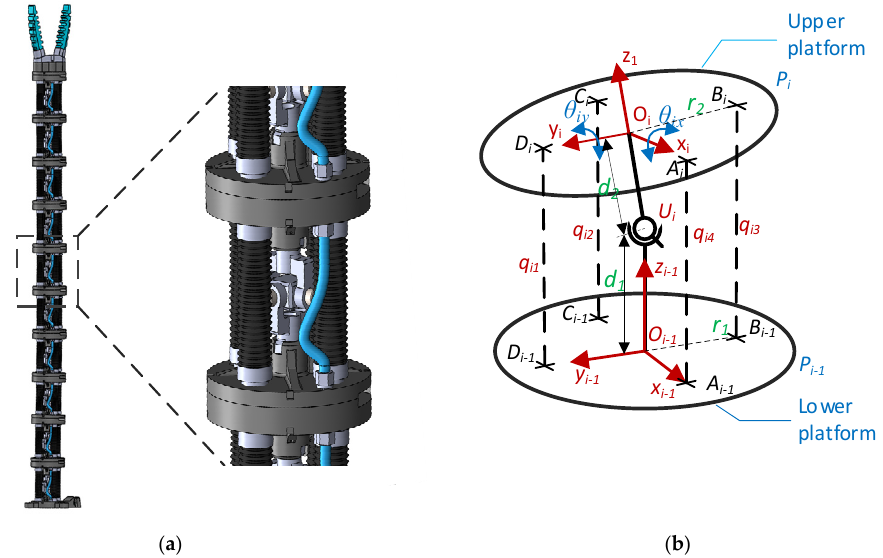
Figure 1. Python Robot ( a ) CAD Model with n = 10 modules ( b ) kinematic diagram of one module.